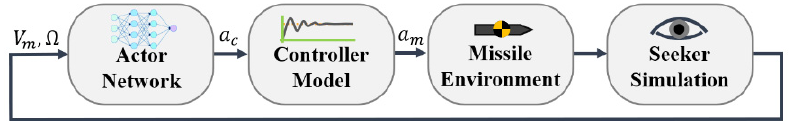
Figure 8. Missile simulation schematic diagram with reinforcement learning (RL).